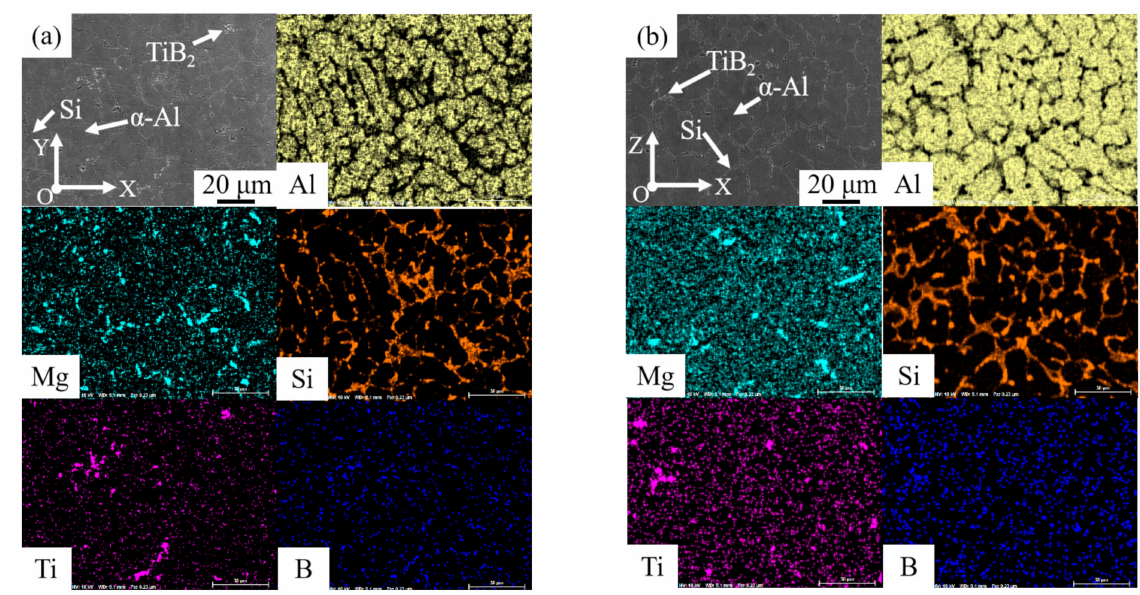
Figure 5. Microstructure of the WAAM-CMT-printed TiB 2 /AlSi7Mg0.6 sample in face XOY ( a ) and XOZ ( b